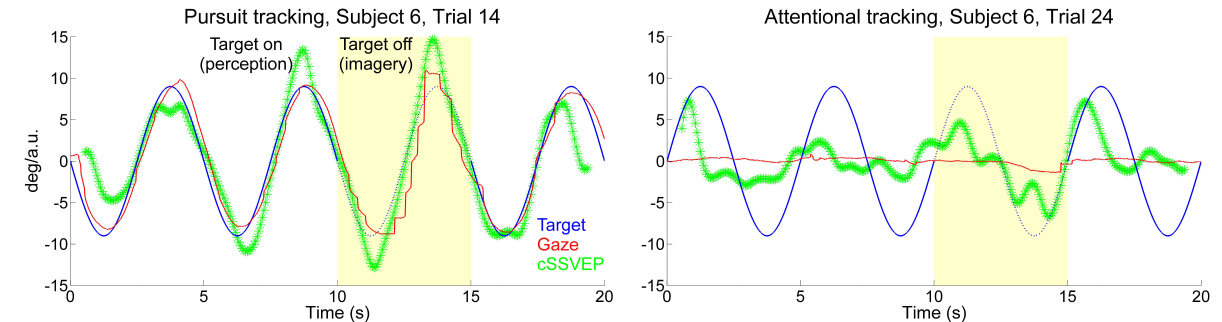
Figure 2: Examples of single-trial cSSVEP recordings (green traces). Data are taken from one representative observer during overt (left panel) and covert (right panel) attentional tracking. Target position and eye position are shown in blue and red, respectively. The yellow transparent patch indicates the imagery